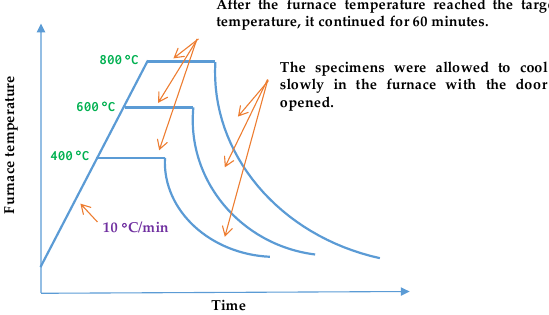
Figure 2. Schematic diagram of specimens heating and cooling in the furnace.